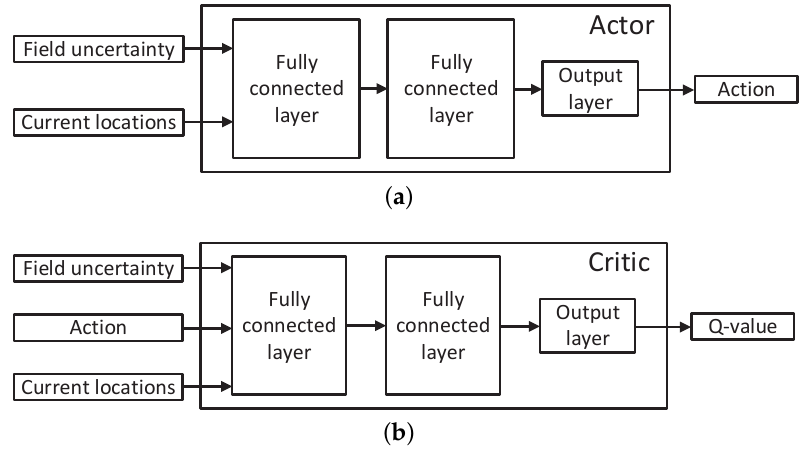
Figure 3. Neural network design in deep deterministic policy gradient (DDPG). ( a ) The forward structure of the actor network; ( b ) the forward structure of the critic